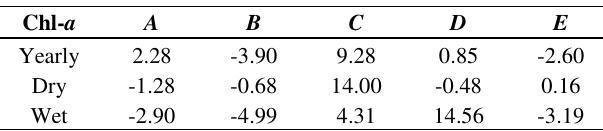
Table 2. Regression coefficient values for Chl- a models.